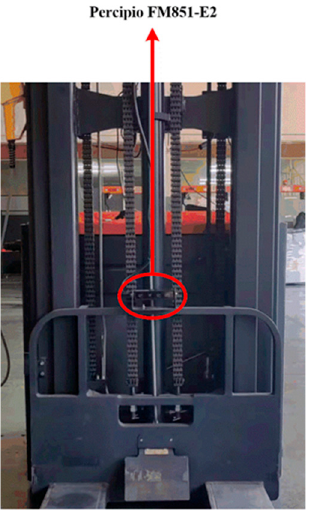
Figure 9. The installation position of the Percipio FM851-E2.